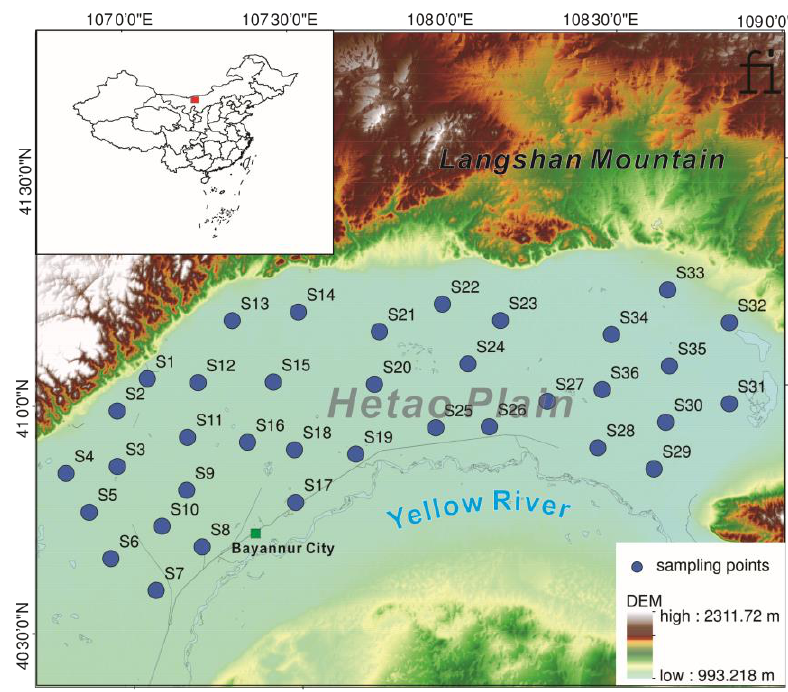
Figure 1. Location of the study area and sample sites.